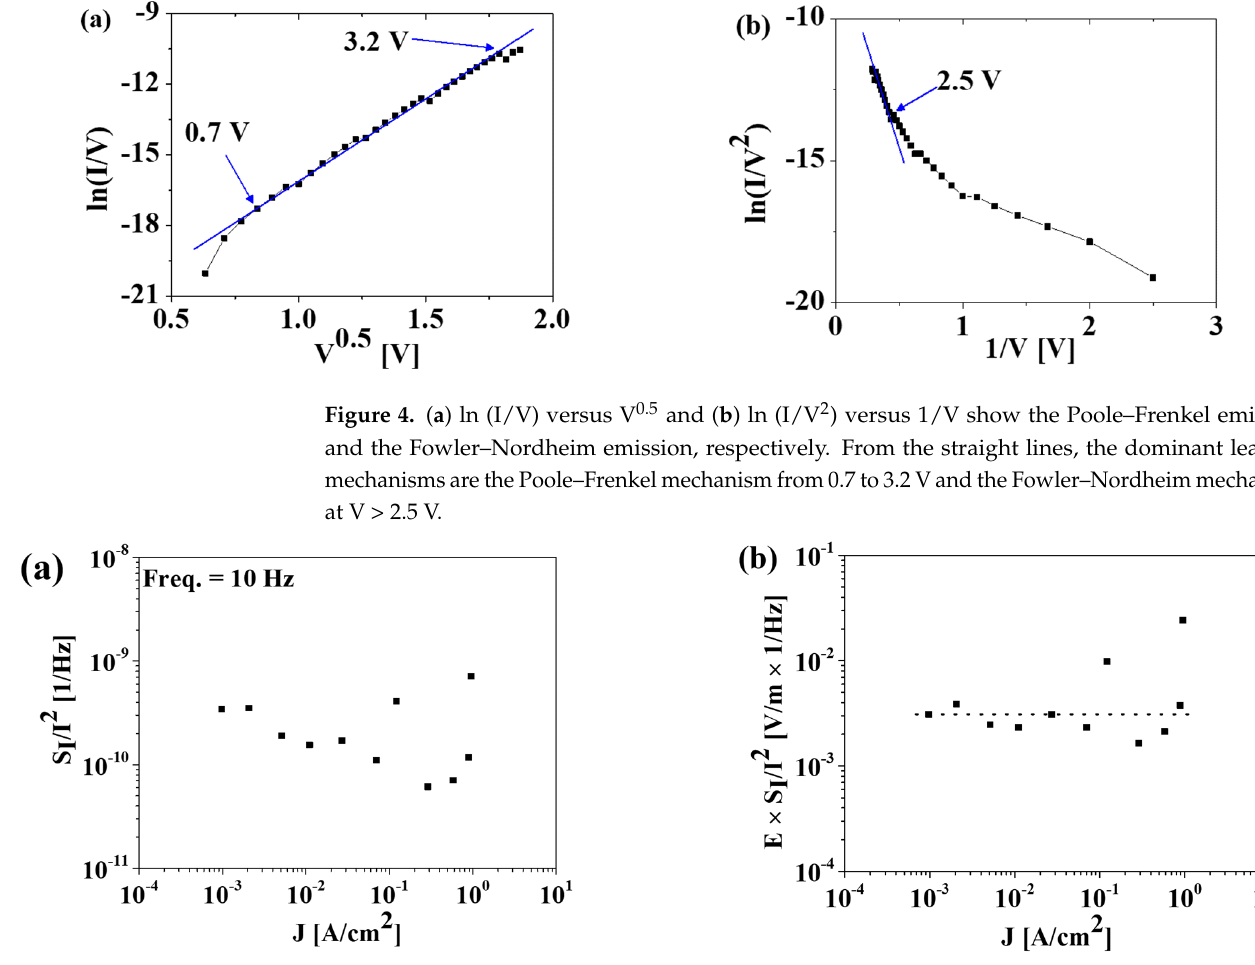
Figure 5. ( a ) S I / I 2 versus J and ( b ) E × S I / I 2 versus J at f = 10 Hz.